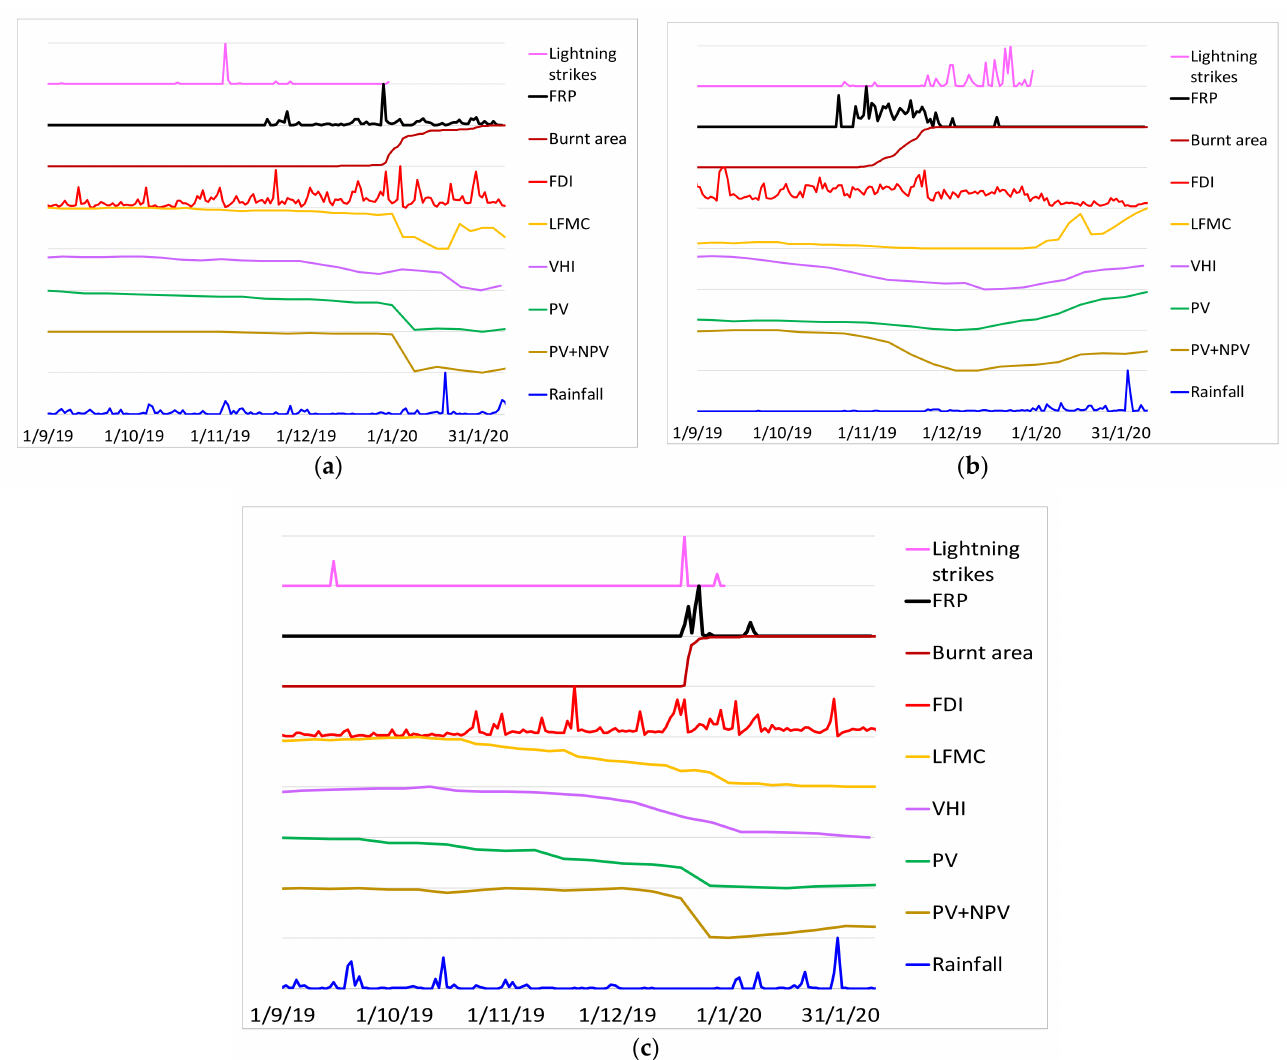
Figure 5. Time series of some of the explanatory and response variables included in this study, averaged over the areas of three Black Summer fires: ( a ) the largest forest fire in Australia’s Black Summer (in east Gippsland, Victoria, Fire ID 25 in our dataset; 9933 km 2 ); ( b ) the largest non-forest fire in Australia’s Black Summer (in the eastern Kimberley, Western Australia, Fire ID 344 in our dataset; 5134 km 2 ); ( c ) a fire in the north of Kangaroo Island, South Australia (Fire ID 1 in our dataset; 170 km 2 ). All variables shown in this figure were normalised between their respective minimum and maximum values to ease the comparison. The acronyms used in the figure are FRP (fire radiative power), FDI (fire danger index), LFMC (live fuel moisture content), VHI (vegetation health index), PV (photosynthetic vegetation), and NPV (non-photosynthetic vegetation) (Tables 1 and